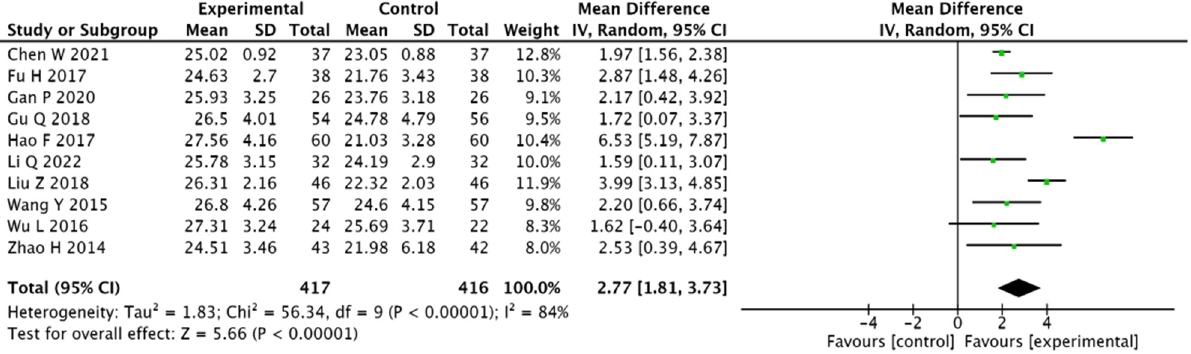
Figure 5. Forest plot of MoCA scores.